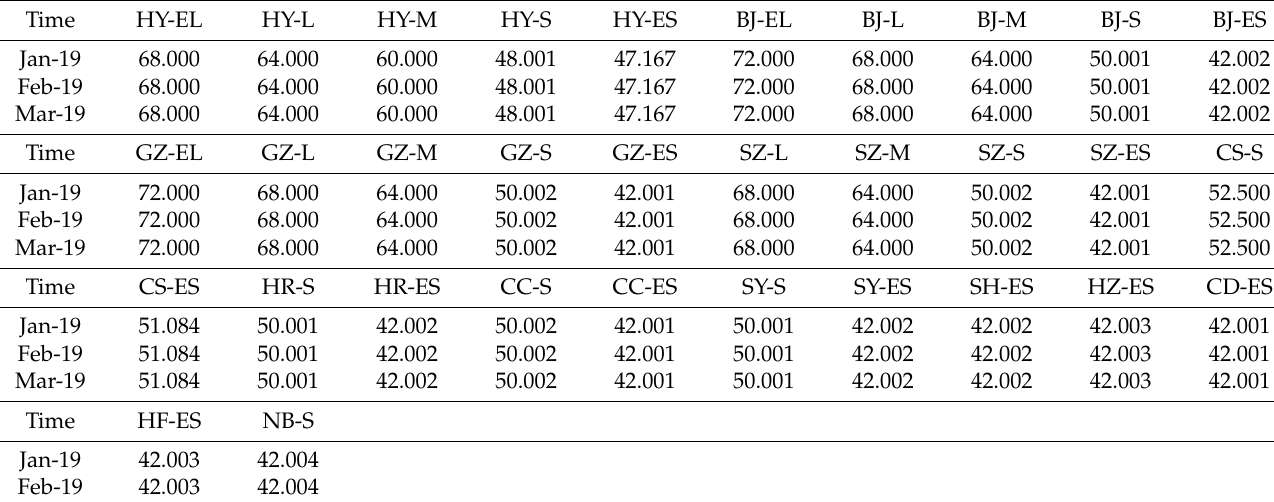
Table 8. The predicted value of each specification price in the HY group (CNY per